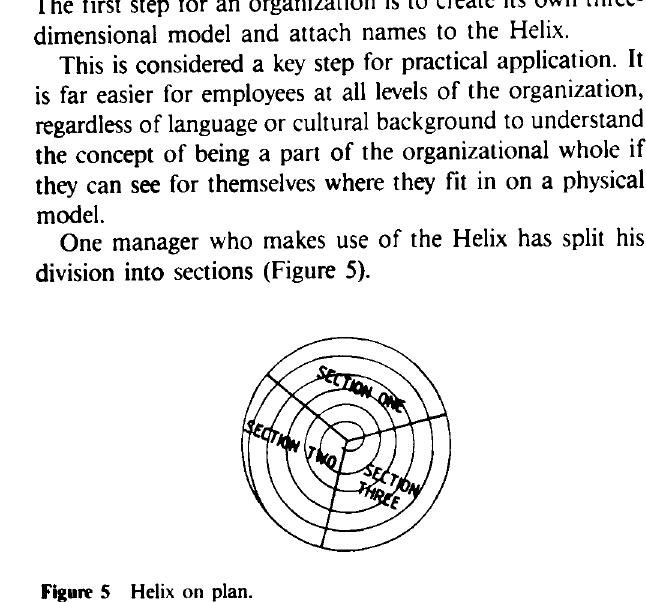
Figure 6 Helix cycle and environmental input